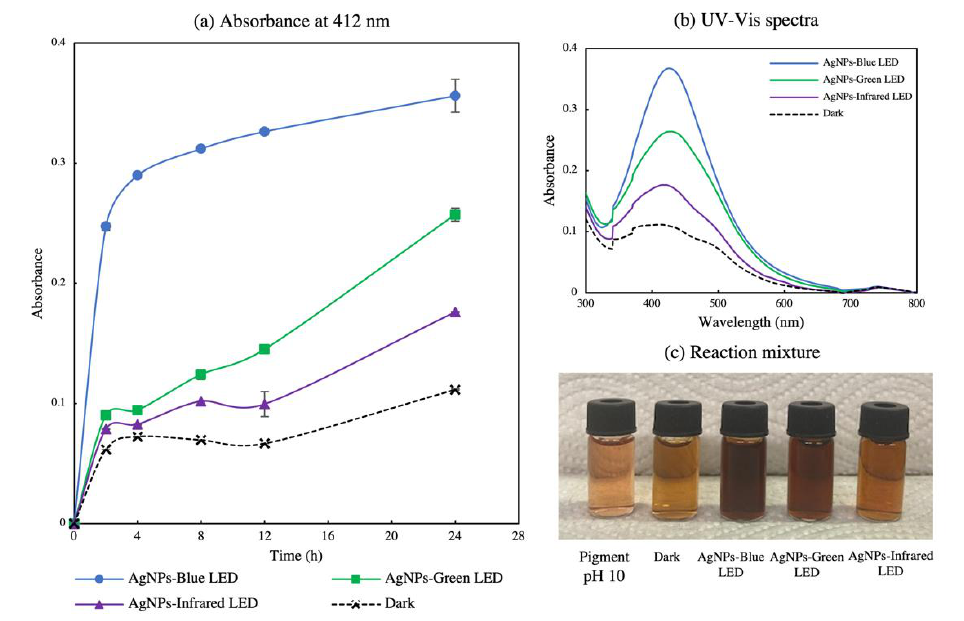
Figure 4. ( a ) Absorbance at 412 nm function of time for the metal salt at the optimized concentration for T. purpurogenus extracellular-pigment-mediated AgNPs’ biosynthesis by blue (AgNPs-blue LED s), green (AgNPs-green LED), and infrared (AgNPs-infrared LED) LEDs. The error bars indicate standard error (n = 3). ( b ) UV – Vis spectra and ( c ) image of reaction mixture upon 24 h.